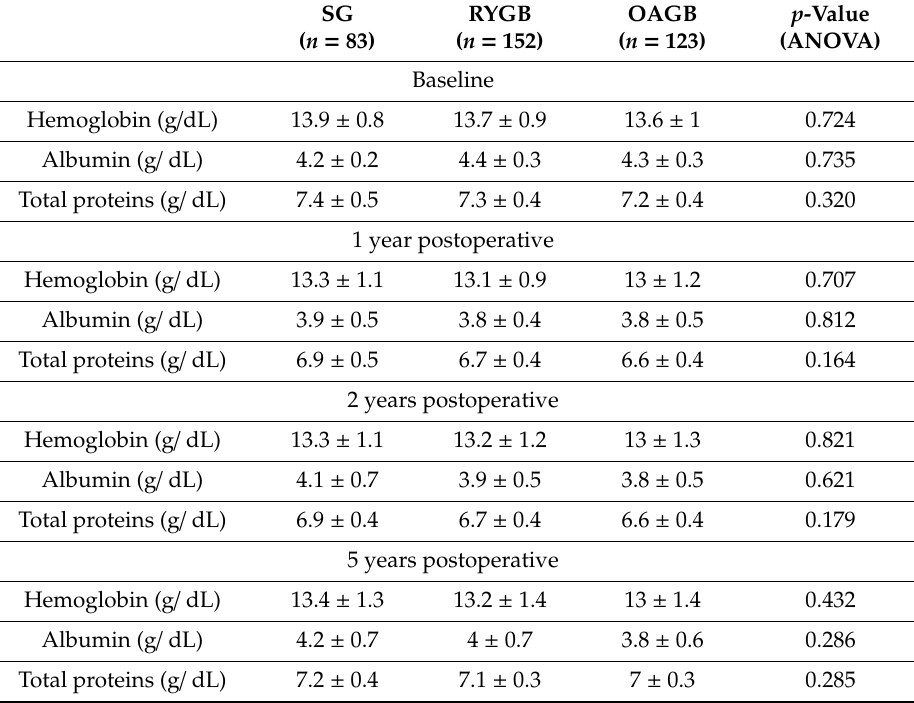
Table 7. Hemoglobin, albumin and total protein levels at 1, 2 and 5 years after